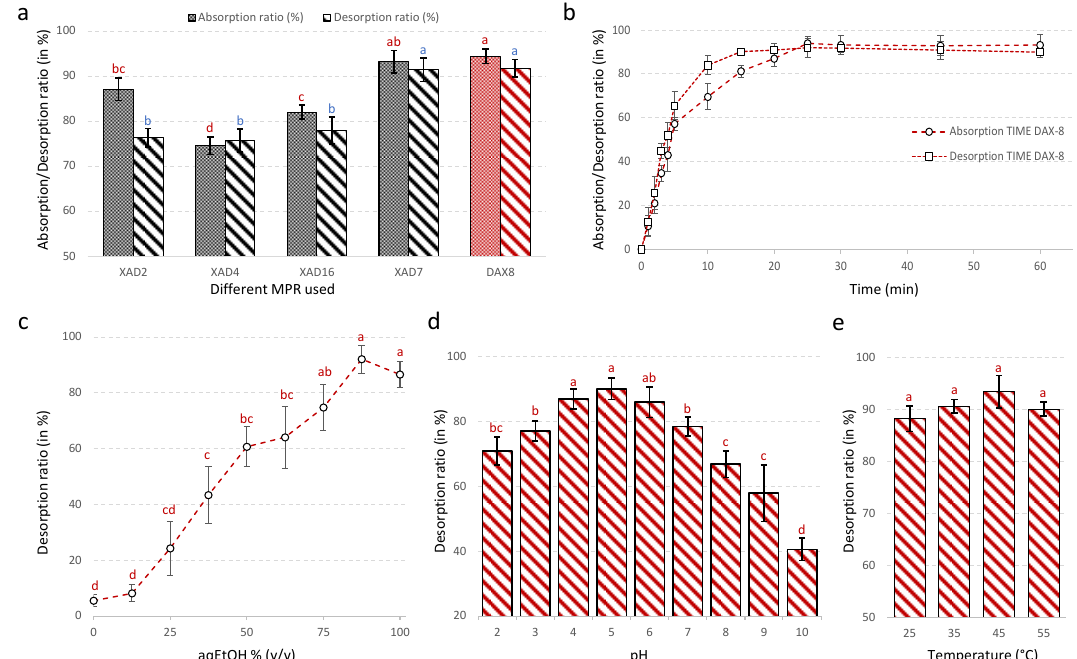
Figure 3. Static adsorption and desorption capacities of the five tested microporous resins for flavonoids from N. lotus stamens. ( a ); Kinetics for static adsorption and desorption on DAX-8 resins for flavonoids from N. lotus stamens ( b ); E ff ect of ethanol concentration on desorption ratio on DAX-8 resins for flavonoids from N. lotus stamens ( c ); E ff ect of pH on desorption ratio on DAX-8 resins for flavonoids from N. lotus stamens ( d ); E ff ect of temperature on desorption ratio on DAX-8 resins for flavonoids from N. lotus stamens ( e ).